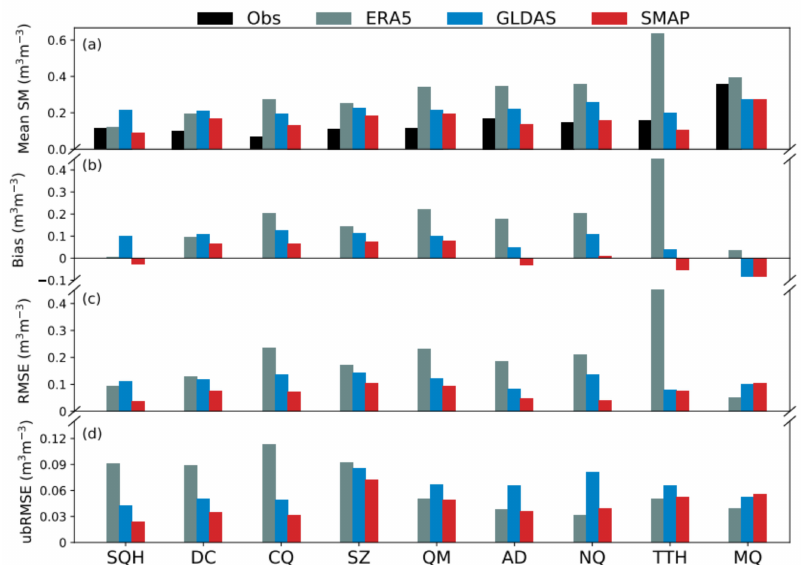
Figure 2. The ( a ) climatology, ( b ) mean bias (Bias), ( c ) root mean square error (RMSE), and ( d ) unbi- ased RMSE (ubRMSE) of product-derived soil moisture (SM) relative to In Situ measurements of SM for May to August in 2017 and 2018 on the Tibetan